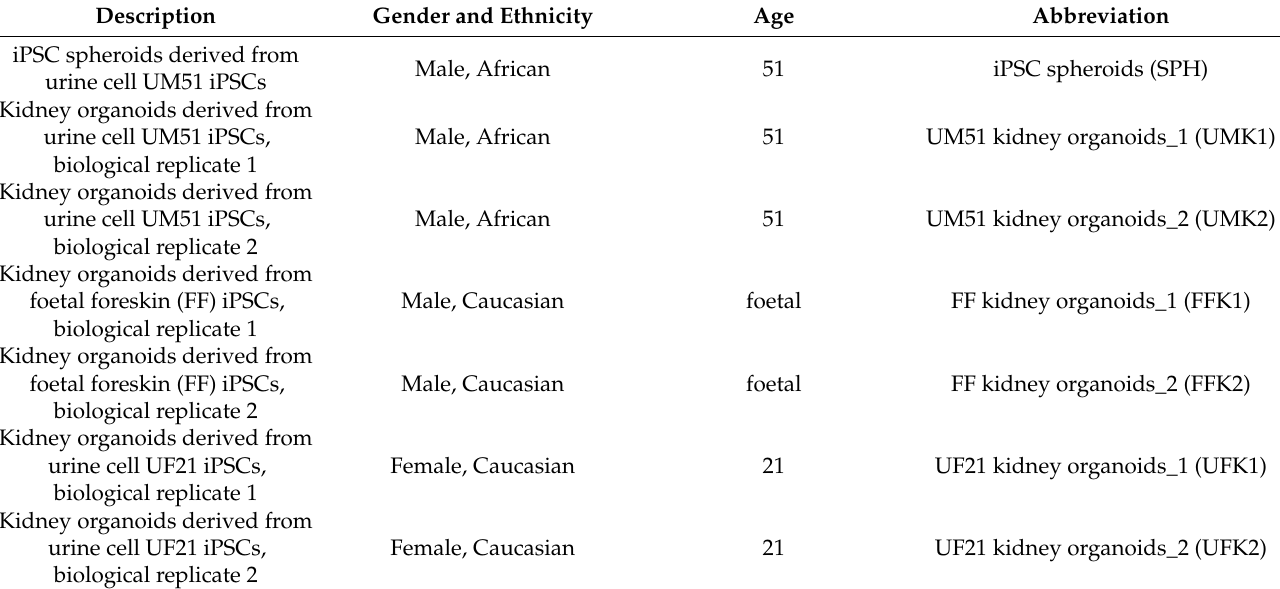
Table 1. Representation of naming for all kidney organoid